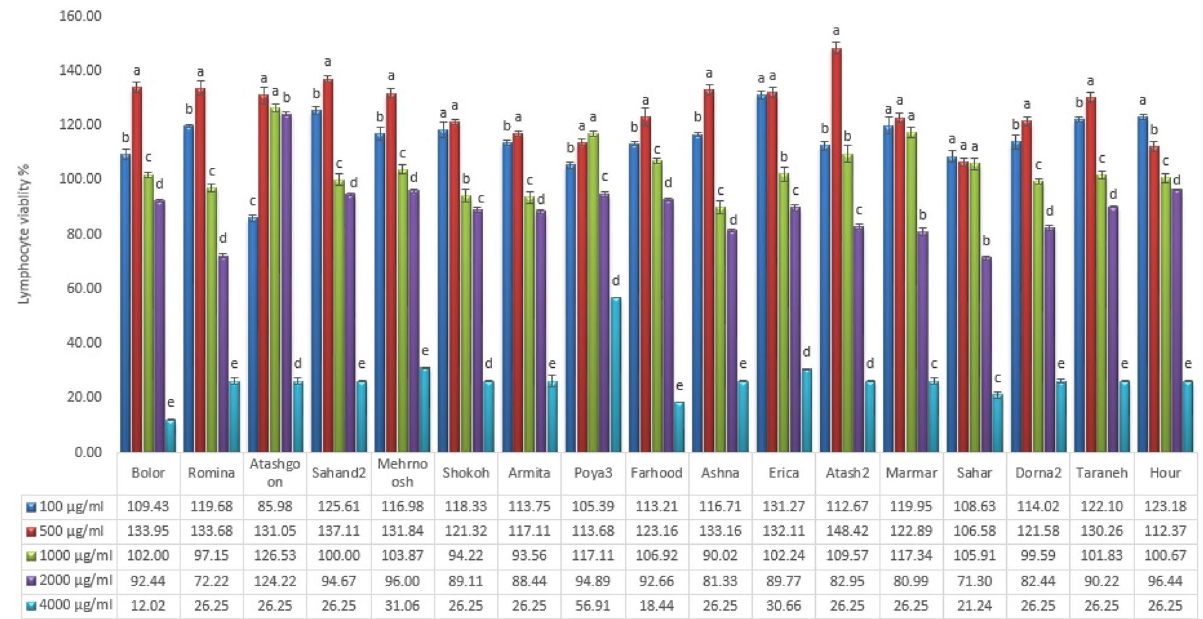
Figure 2. Cell viability of human lymphocyte cells against methanol extract of Chrysanthemum cultivars (Data are presented as normalized mean values ± SD (n =